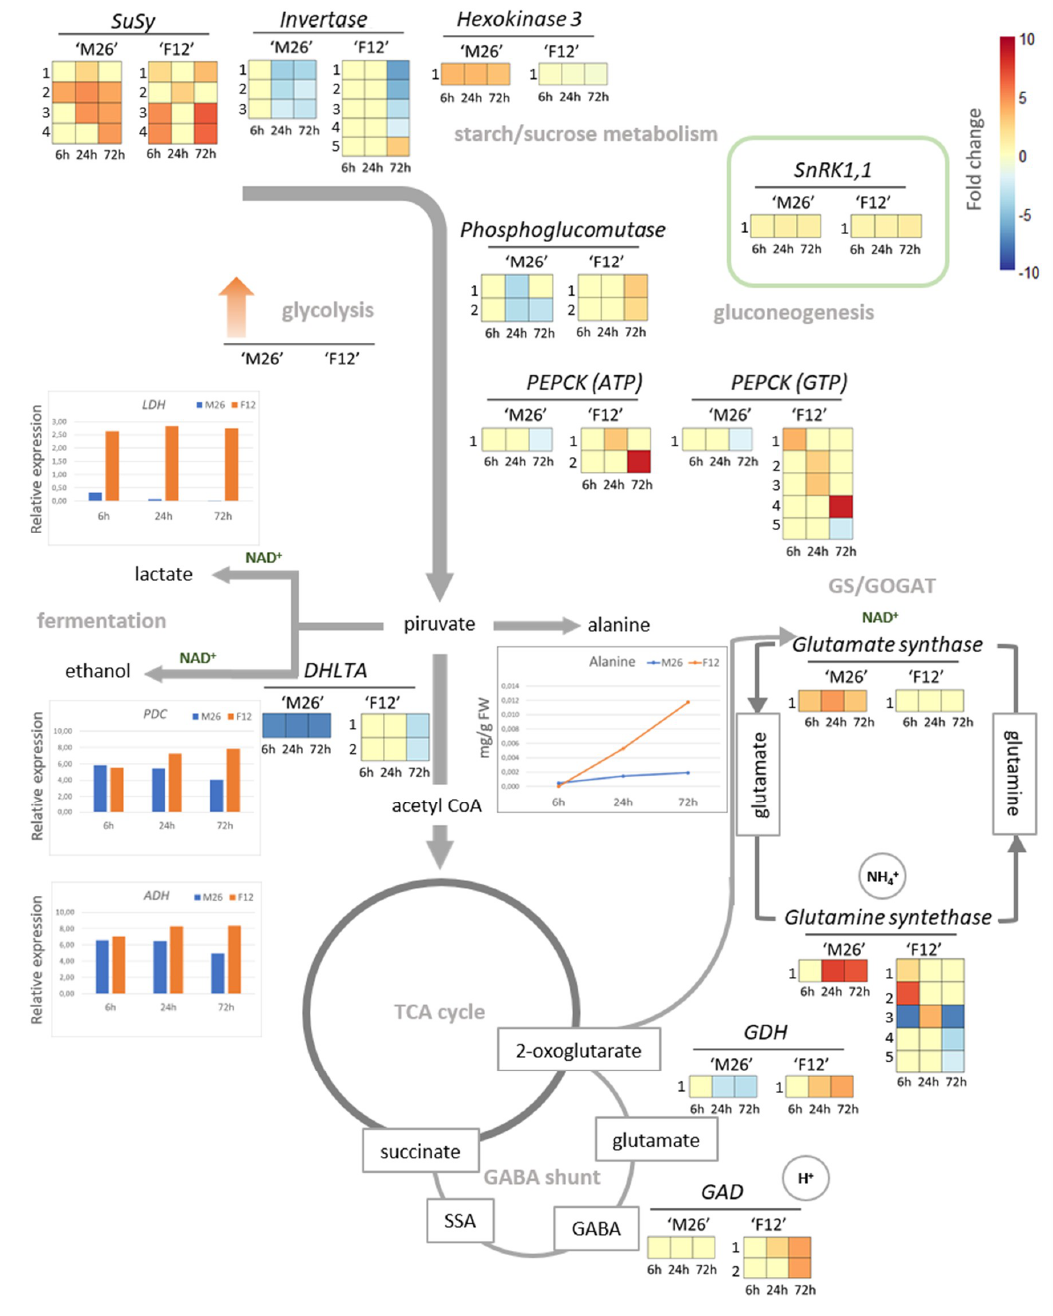
Figure 1. Transcriptomic reconfiguration of pathways involved in energy metabolism in response to O 2 deficiency. Through a comparative analysis between two genotypes of Prunus rootstocks, the hypoxia-tolerant ‘Mariana 2624’ (‘M26′) and the hypoxia-sensitive ‘Mazzard F12/1’ (‘F12′), the